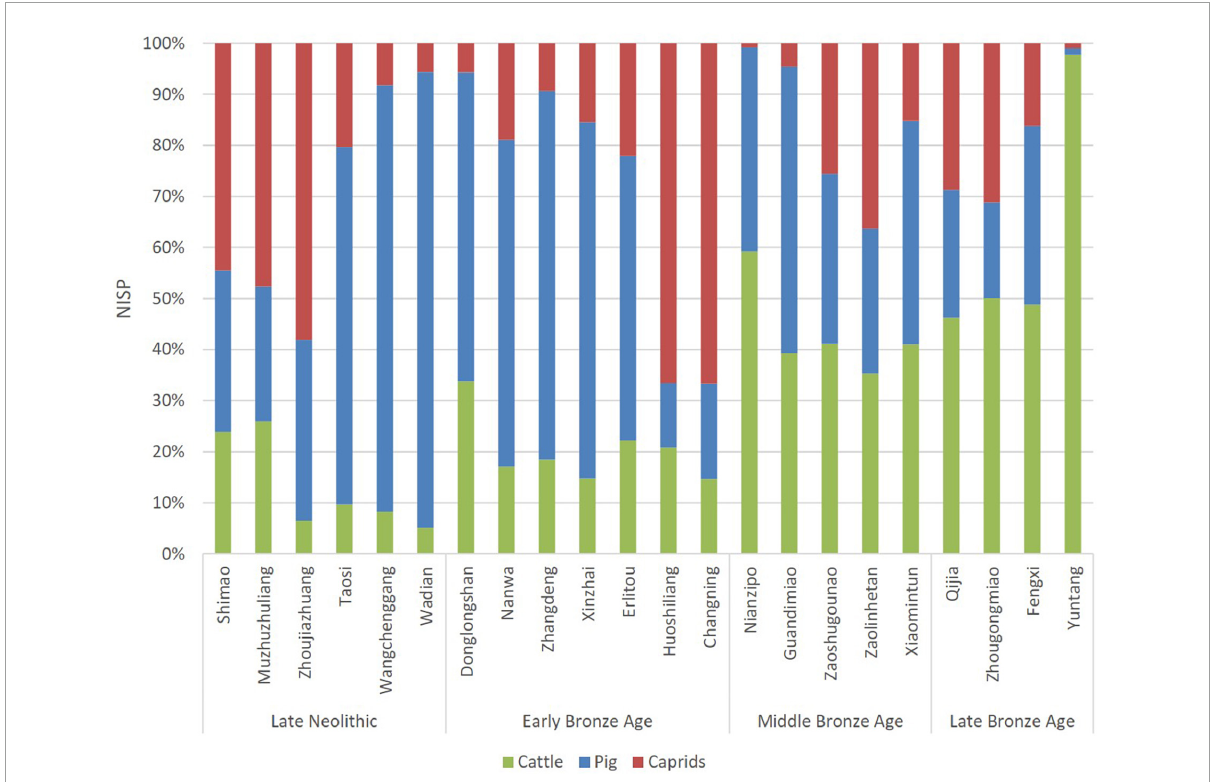
FIGURE4 Relative proportions of cattle remains among cattle, pig, and caprids NISP of the studied